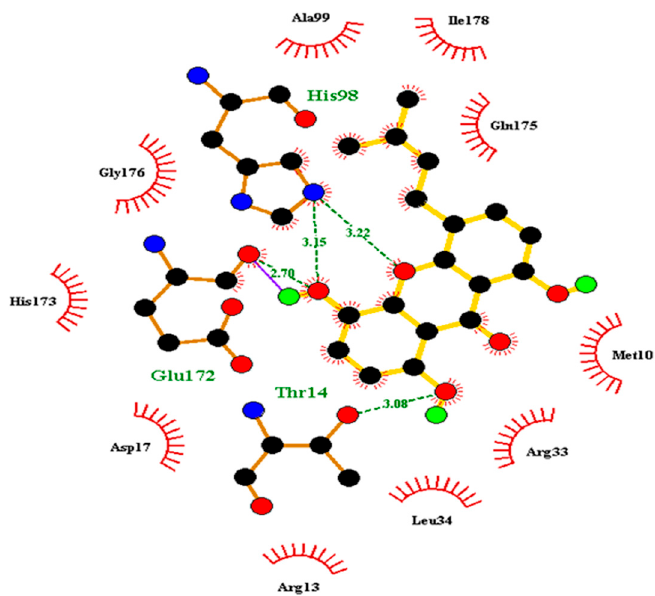
Figure 9. Ligplot of ZINC000095485921 showing the ligands interactions pre–IFD. Ligand is shown in yellow and hydrogen bonds are shown in green broken lines. Refer to Figure S1 for the ligplots of the other lead compounds.